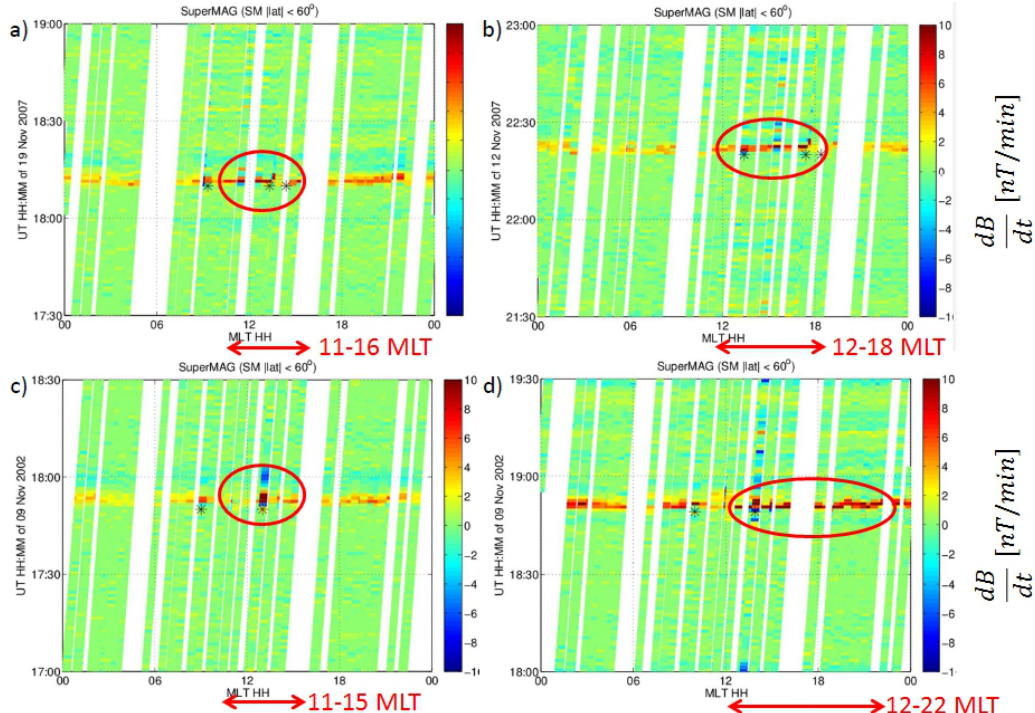
Fig. 4. Low and mid latitude ( < 60 degrees) ground observation of the time variation of the magnetic field (in nT/min) from SuperMAG data. The black stars denote MLT of the GOES spacecraft on the geostationary orbit. The upper left picture (a) represents event 1: November 19, 2007. The upper right picture (b) represents event 2: November 12, 2007. The lower two pictures (c, d) illustrate the event investigated in our previous study (Andr´eeov´a, 2009): November 09, 2002 at 1750 UT and 1849 UT. Red ovals highlight the intensification areas, whereas red arrows show the time interval in MLT.